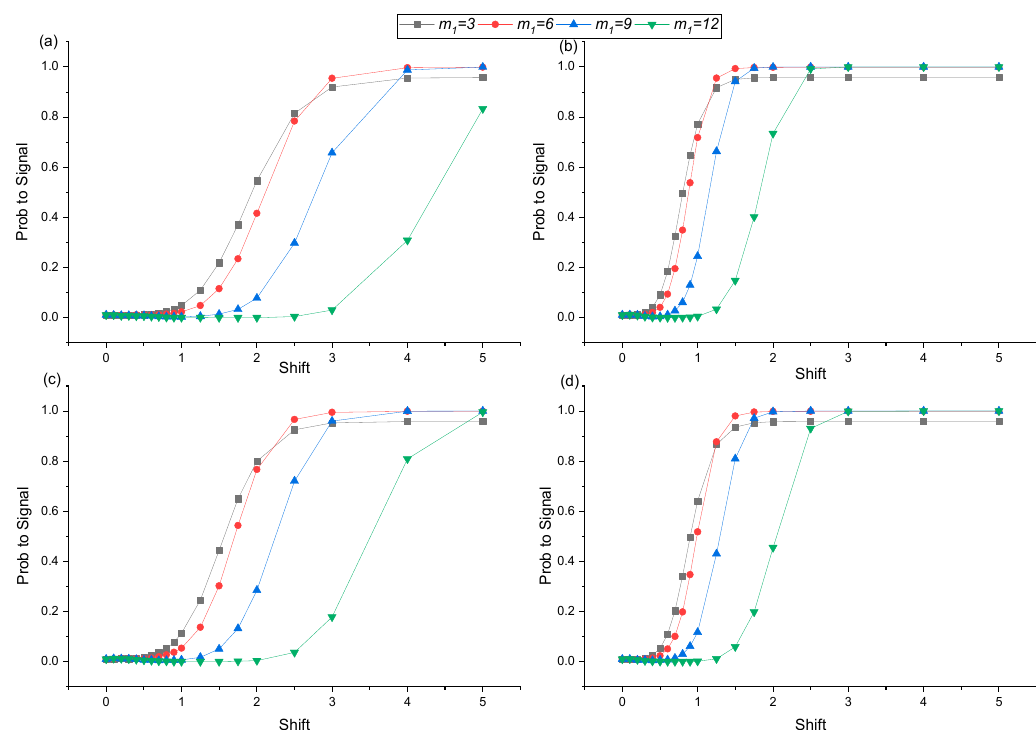
Figure 8. Probability to signal plot for di ff erent m 1 values using m = 30, n = 10 and α = 0.01 of: ( a ) M 3 and ρ = 0.50; ( b ) M 3 and ρ = 0.95; ( c ) M 4 and ρ = 0.50; ( d ) M 4 and ρ =